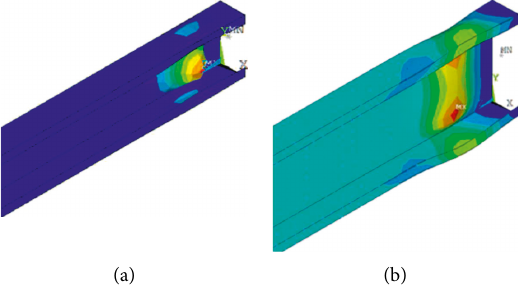
Figure 25: Buckling mode of C90-0.9-600-A (a) and failure mode of C140-1.5-600-WM